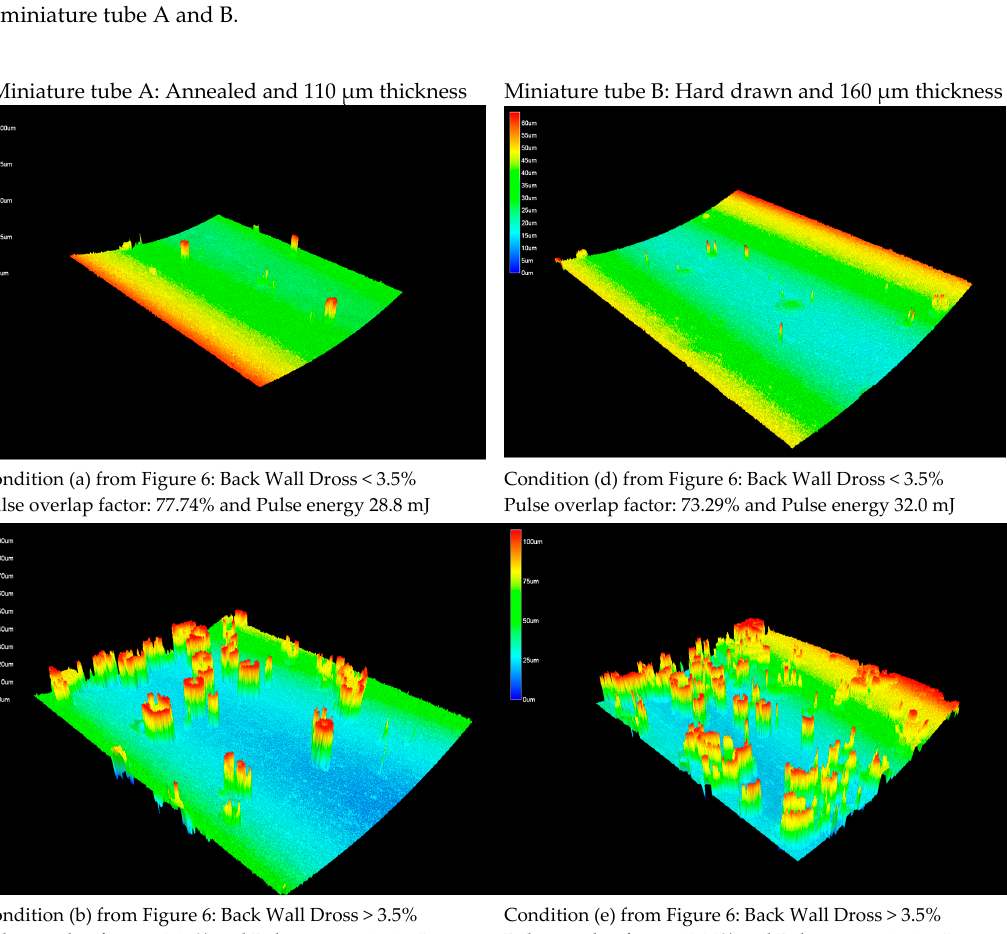
Figure 8. Confocal microscopy images of back wall surface topography. In condition ( a ): Back Wall Dross < 3.5%, condition ( b ): Back Wall Dross > 3.5%, condition ( d ): Back Wall Dross < 3.5%, and condition ( e ): Back Wall Dross > 3.5%.